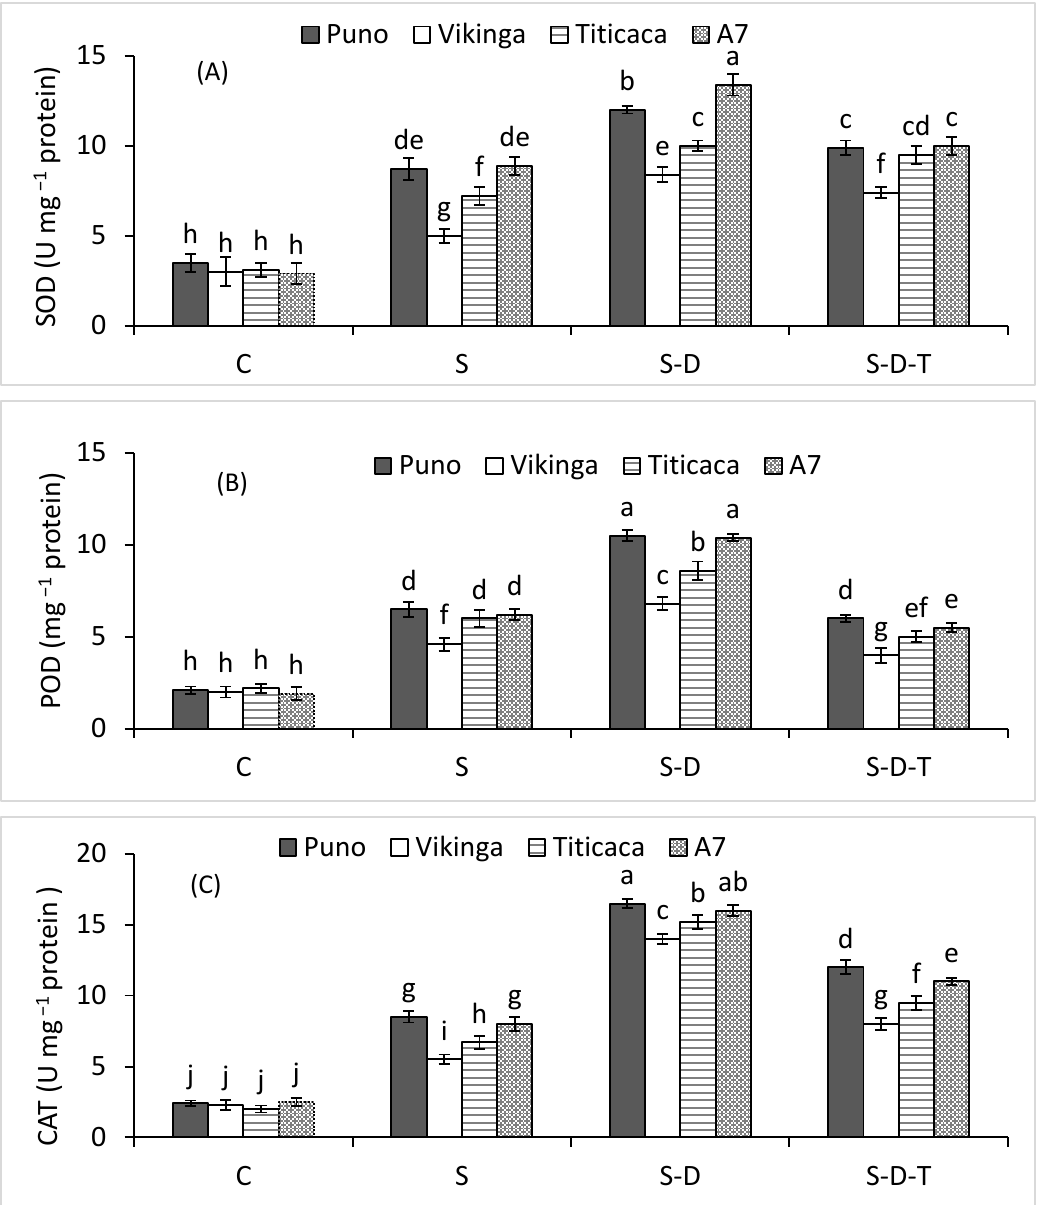
Figure 5. ( A ) SOD, ( B ) POD, and ( C ) CAT activities of quinoa genotypes under control (C), salinity (S), drought (D), and high-temperature (T) stress. S-D, combined salinity and drought treatment; S-D-T, combined salinity, drought, and high-temperature treatment. The values for each parameter are the means of three replicates ± SE. At the 5% probability level, bars with different letters indicate significant